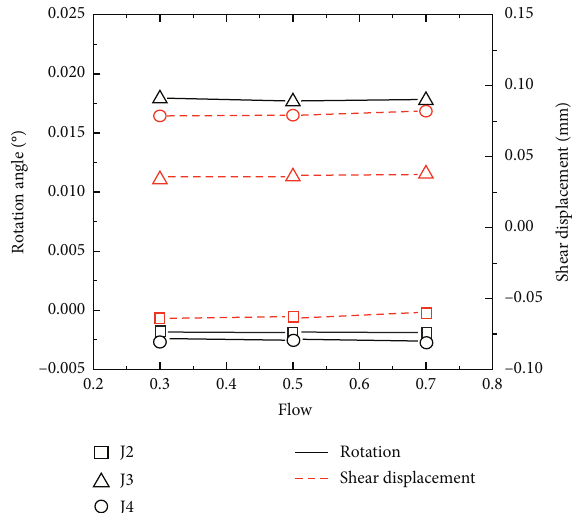
Rotation displacementJ2 Shear J3 Figure 16: Influence of flow on joint rotation and under different flow shear